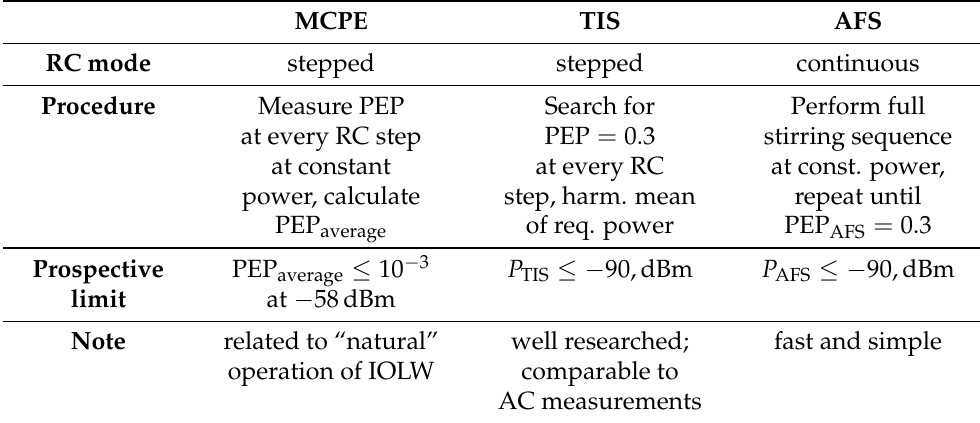
Table 3. Comparison of the sensitivity test methods, as described in this section. MCPE TIS AFS RC mode